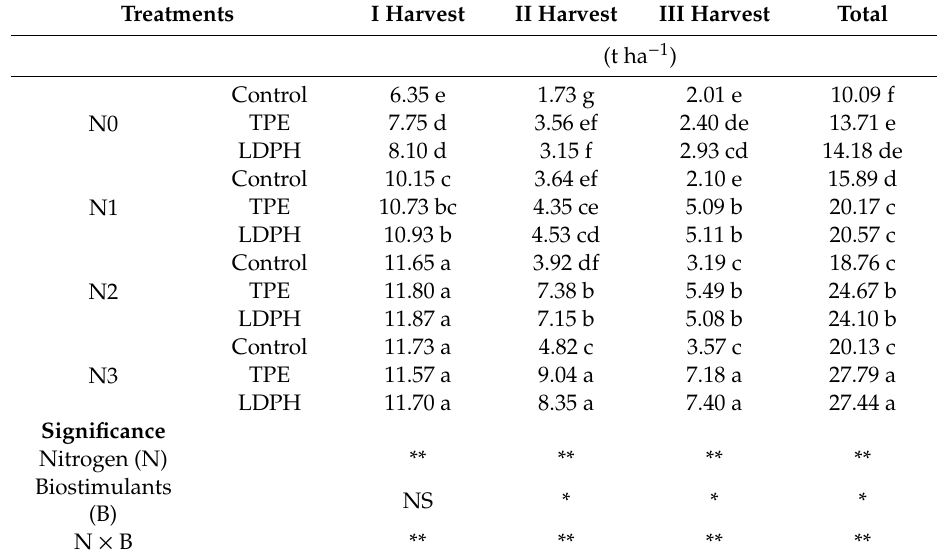
Table 1. Baby rocket leaf marketable yield at di ff erent harvest dates in relation to N fertilization rates extract (TPE): Auxym and legume-derived protein hydrolysate (LDPH):